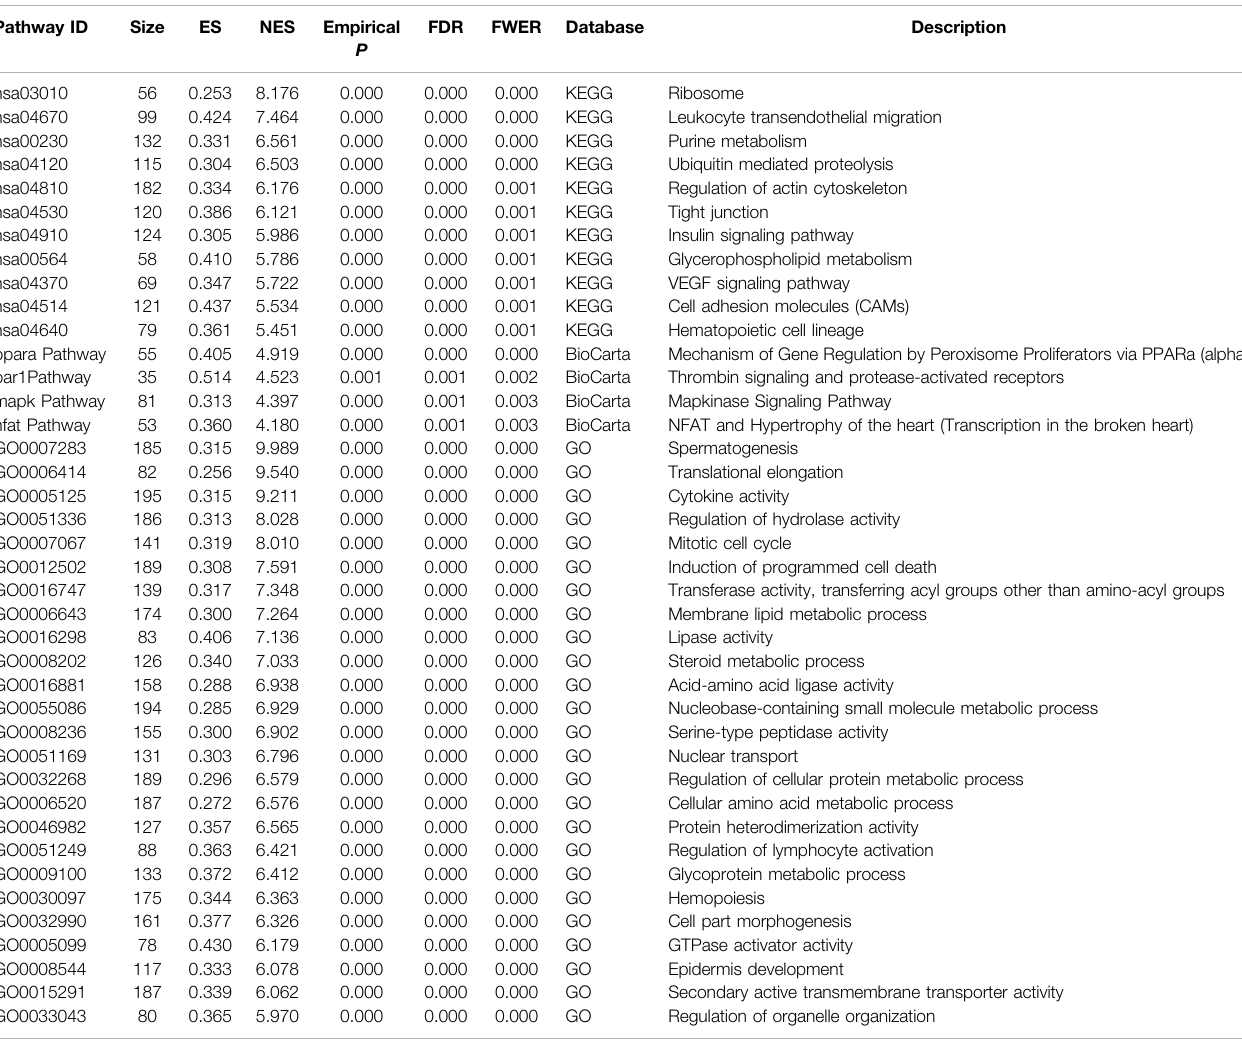
TABLE 2 | Pathway association studies for plasma cystatin C. Pathway